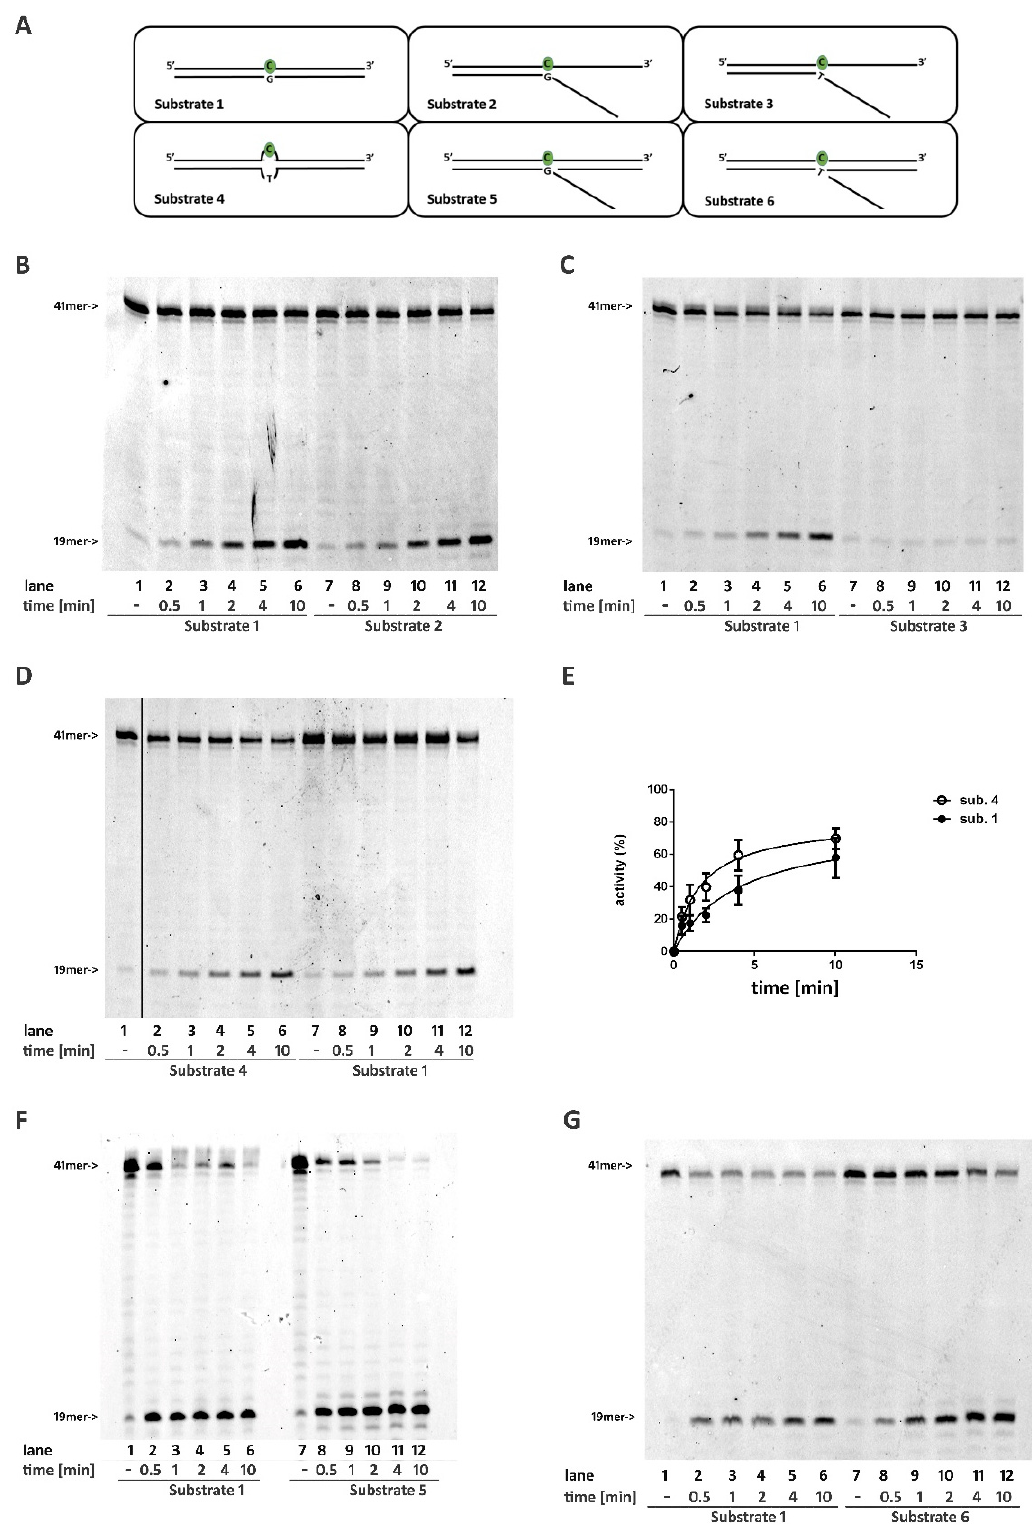
Figure 1. Base pairing at the 3 ′ of an embedded ribonucleotide is not required for RNaseH2 activity. Time course reactions were performed as described in materials and methods using 20 nM nucleic acid substrates and 0,4 nM RNase H2. ( A ) Schematic representation of substrates used. Enzyme activity was compared between ( B ) Substrates 1 and 2; ( C ) Substrates 1 and 3; ( D ) Substrates 1 and 4; ( F ) Substrates 1 and 5; ( G ) Substrates 1 and 6. Unprocessed substrates and reaction products are indicated at the left of each panel (41-mer and 19-mer respectively). Black vertical line in ( D ) represents the cropped area in the raw picture. ( E ) Quantification of three independent experiments measuring RNase H2 activity using substrate 1 and